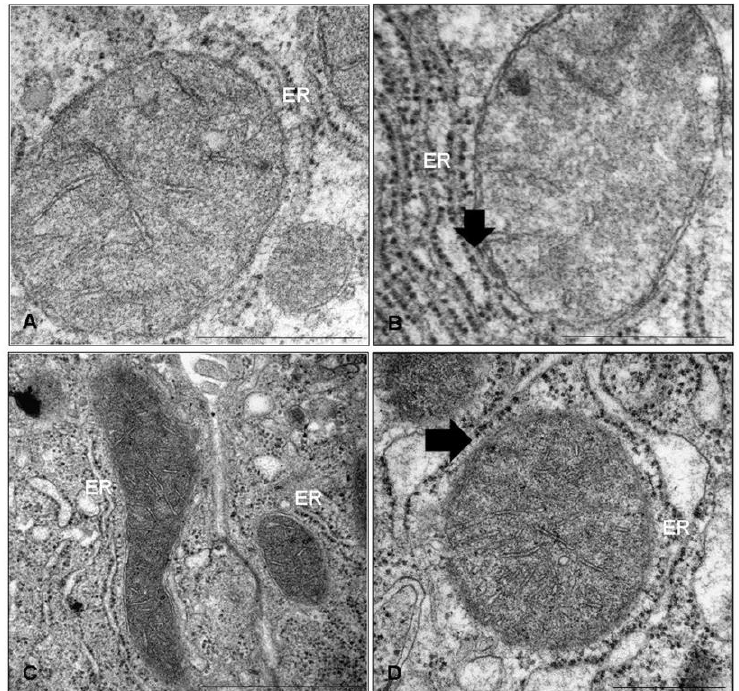
Figure 1. Mitochondria-associated endoplasmic reticulum membranes (MAMs) ultrastructure in adult mice liver changed with nutrition. ( A ) C57BL6/J mice liver fed a maintenance diet; ( B ) leptin-deficient obese mice presented abnormal endoplasmic reticulum (ER) cisternae and narrowing of contacts; ( C ) repeated starved C57BL6/J mice showed regular distance and elongated mitochondria; ( D ) repeated starved sirtuin 1 heterozygous mice presented close ER-mitochondria contact and swollen cisternae. (ER): Endoplasmic reticulum; arrows identify MAM narrowing. Scale bar: A, B, D 500 nm; C 1 µm.